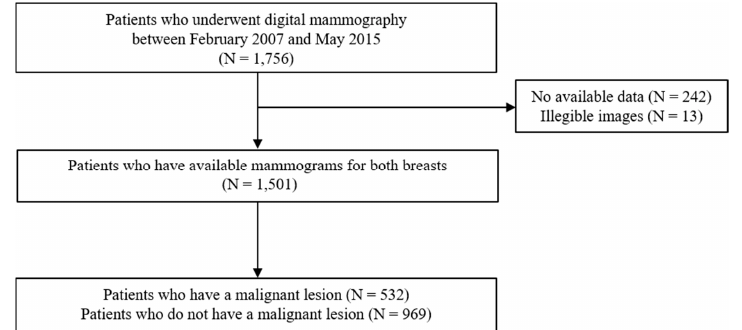
Figure 1. Flow diagram for the subject enrollment in this study.